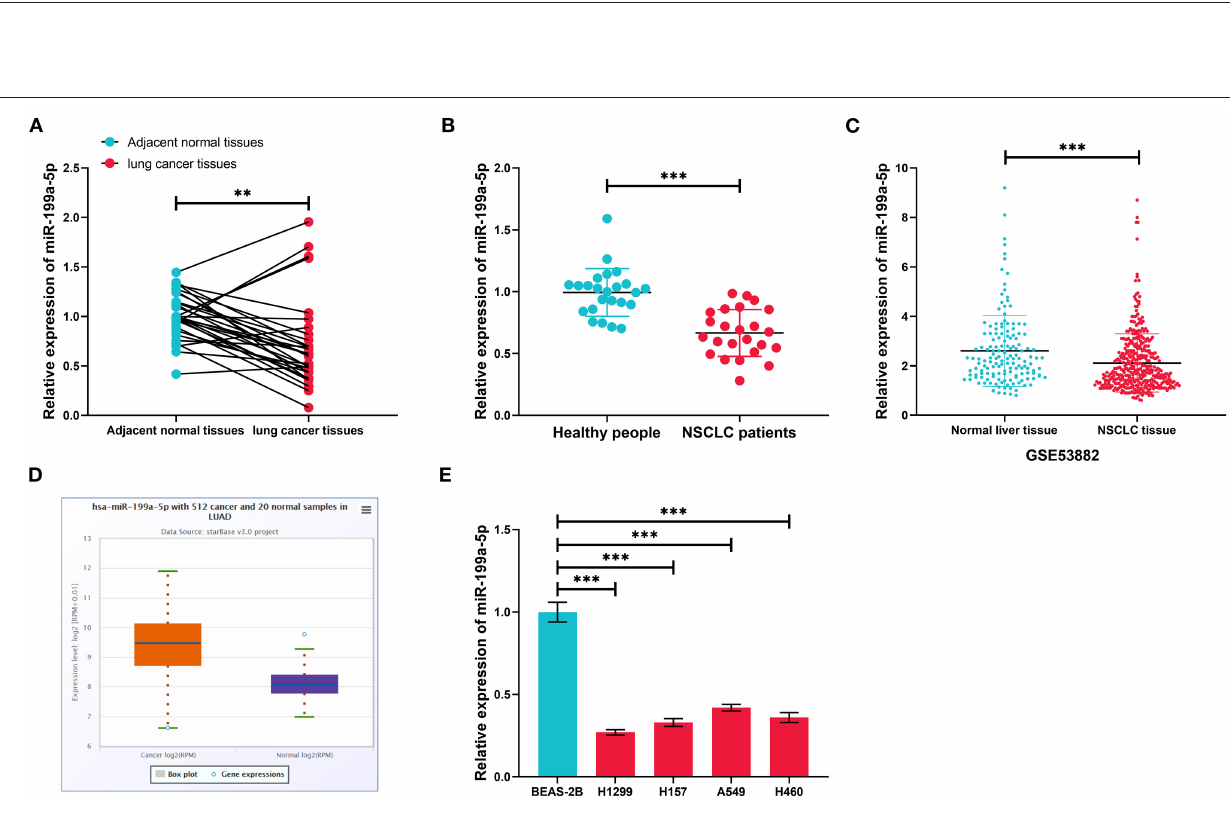
Frontiers in Cell and Developmental Biology |